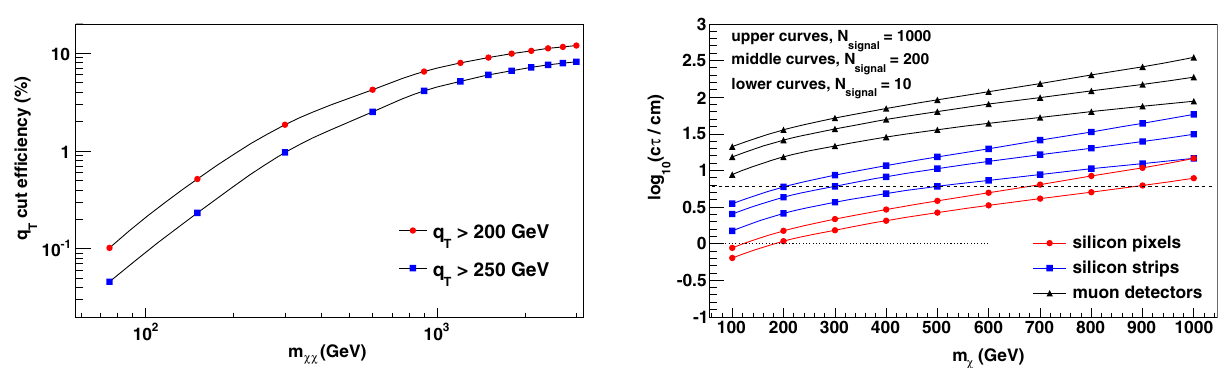
Figure 5. (Left) The efficiency of requiring a minimum χχ -system transverse momentum q T , imparted by initial-state QCD radiation (ISR). The efficiency is estimated using the dyqt program 61,62 for √ s at the LHC and is shown as a function of the system invariant mass. (right) The reduced discovery reach for metastable winos and higgsinos, after folding in the efficiency of the minimum q T requirement, to be compared to Fig. 4, also for an integrated luminosity of 3 ab − 1 at the high-luminosity